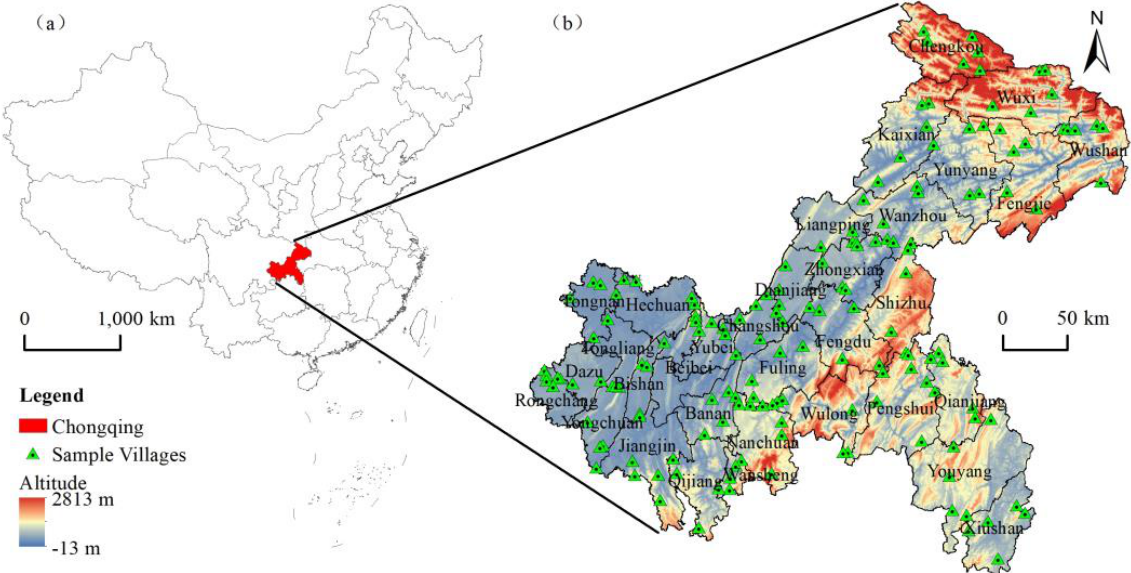
Figure 1. ( a ) Location of Chongqing in China. ( b ) Districts and counties in Chongqing. Notes: Figure 1. Location of Chongqing in China. Notes: According to the main function division of the According to the main function division of the Chongqing Municipality and considering the integrity Chongqing Municipality and considering the integrity of administrative divisions, 38 districts and of administrative divisions, 38 districts and counties are divided into three categories: the counties are divided into three categories: the main urban area (Yuzhong District, Jiangbei District,